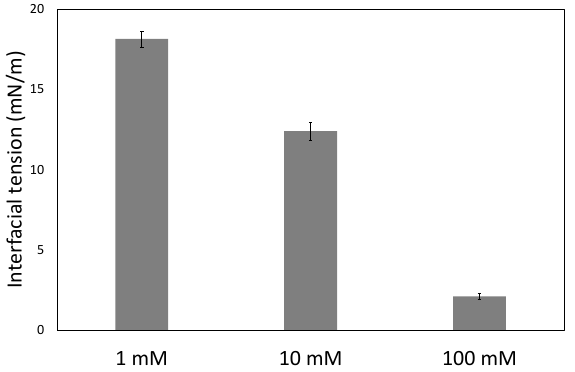
Figure 4. Interfacial tension of the oil-water interface in presence of SDS for 1, 10 and 100 mM of NaCl and 463 mg/L SDS. Error bars represent the standard deviation after duplicates.